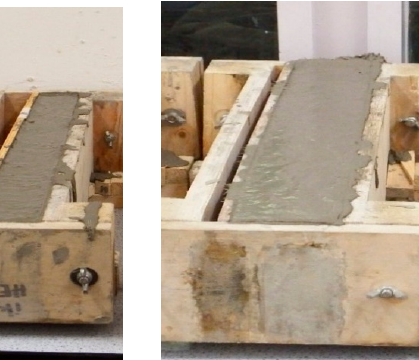
Figure 1. Preparation of prisms with different depths.